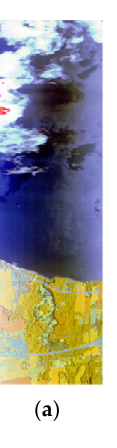
Figure 7. HSI2 Hyperspectral images over Lake Erie ( a ) Image 1 (white—clouds, blue—water, yellow—land), and ( b ) Image 2 (white—clouds, green—water, red—land).